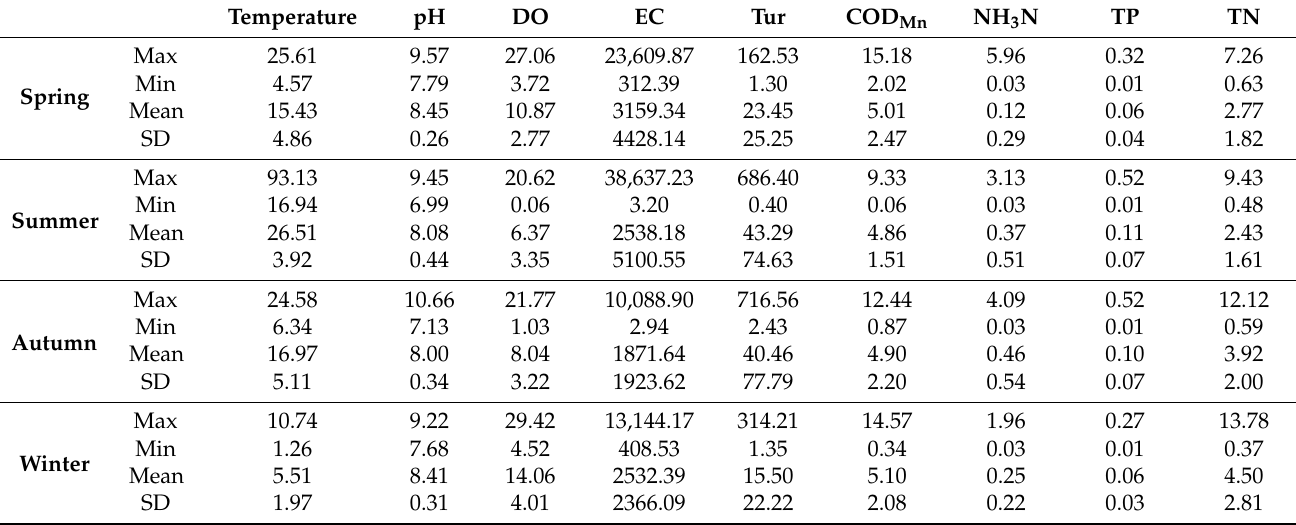
Table 1. Seasonal statistical characteristics of surface water in